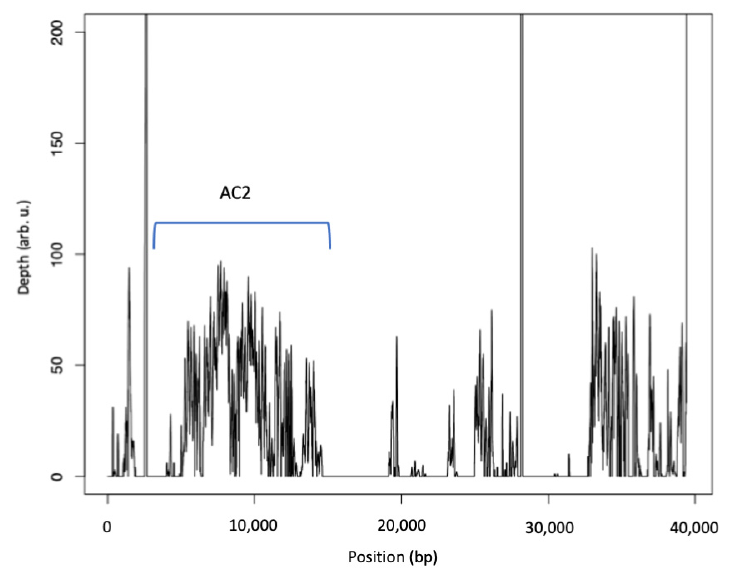
Figure 4. Coverage of accession KL656922 representing the AC2 of IBT 40288 (A-type strain) by sequences derived from IBT 40293 (S-type strain). The position of the AC2 is indicated.